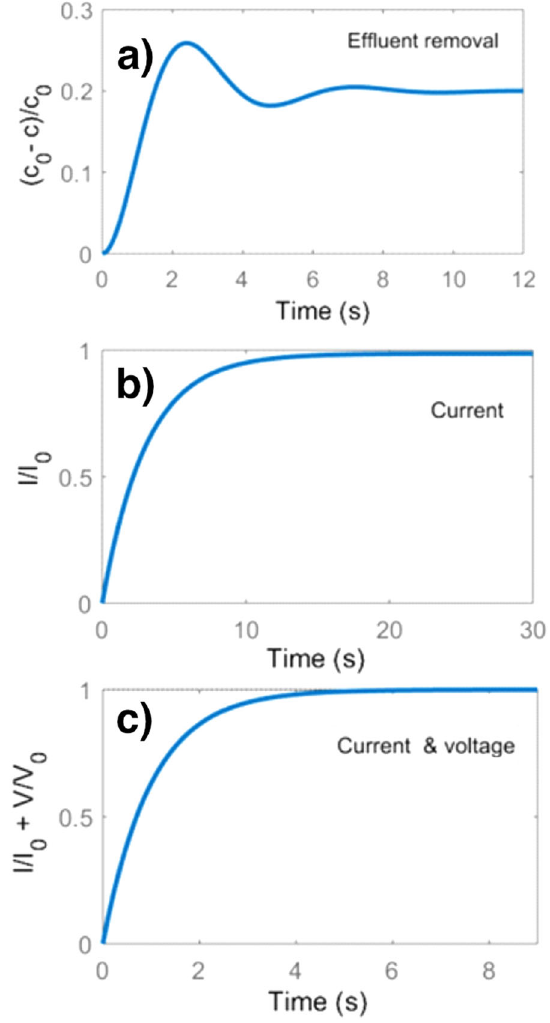
Fig. 5 Response from a CDI control system. A state-space model was derived from Eq. 11 and the parameter fi tting in Fig. 3. A PID controller was automatically tuned to this system using the tool in Supplementary Note 1 so that the model output y will approach a supplied reference signal r . The graphs show simulated step responses for the controlled CDI system, under various outputs y . a The output is the concentration y = ( c 0 − c )/ c 0 and the reference value is r = 0.2. b The output is the current y = I / I 0 ( I 0 = 100[ mA ]) and the reference value is r = 1. c As an example of combined CC/CV operation, the output is a combination of the current and